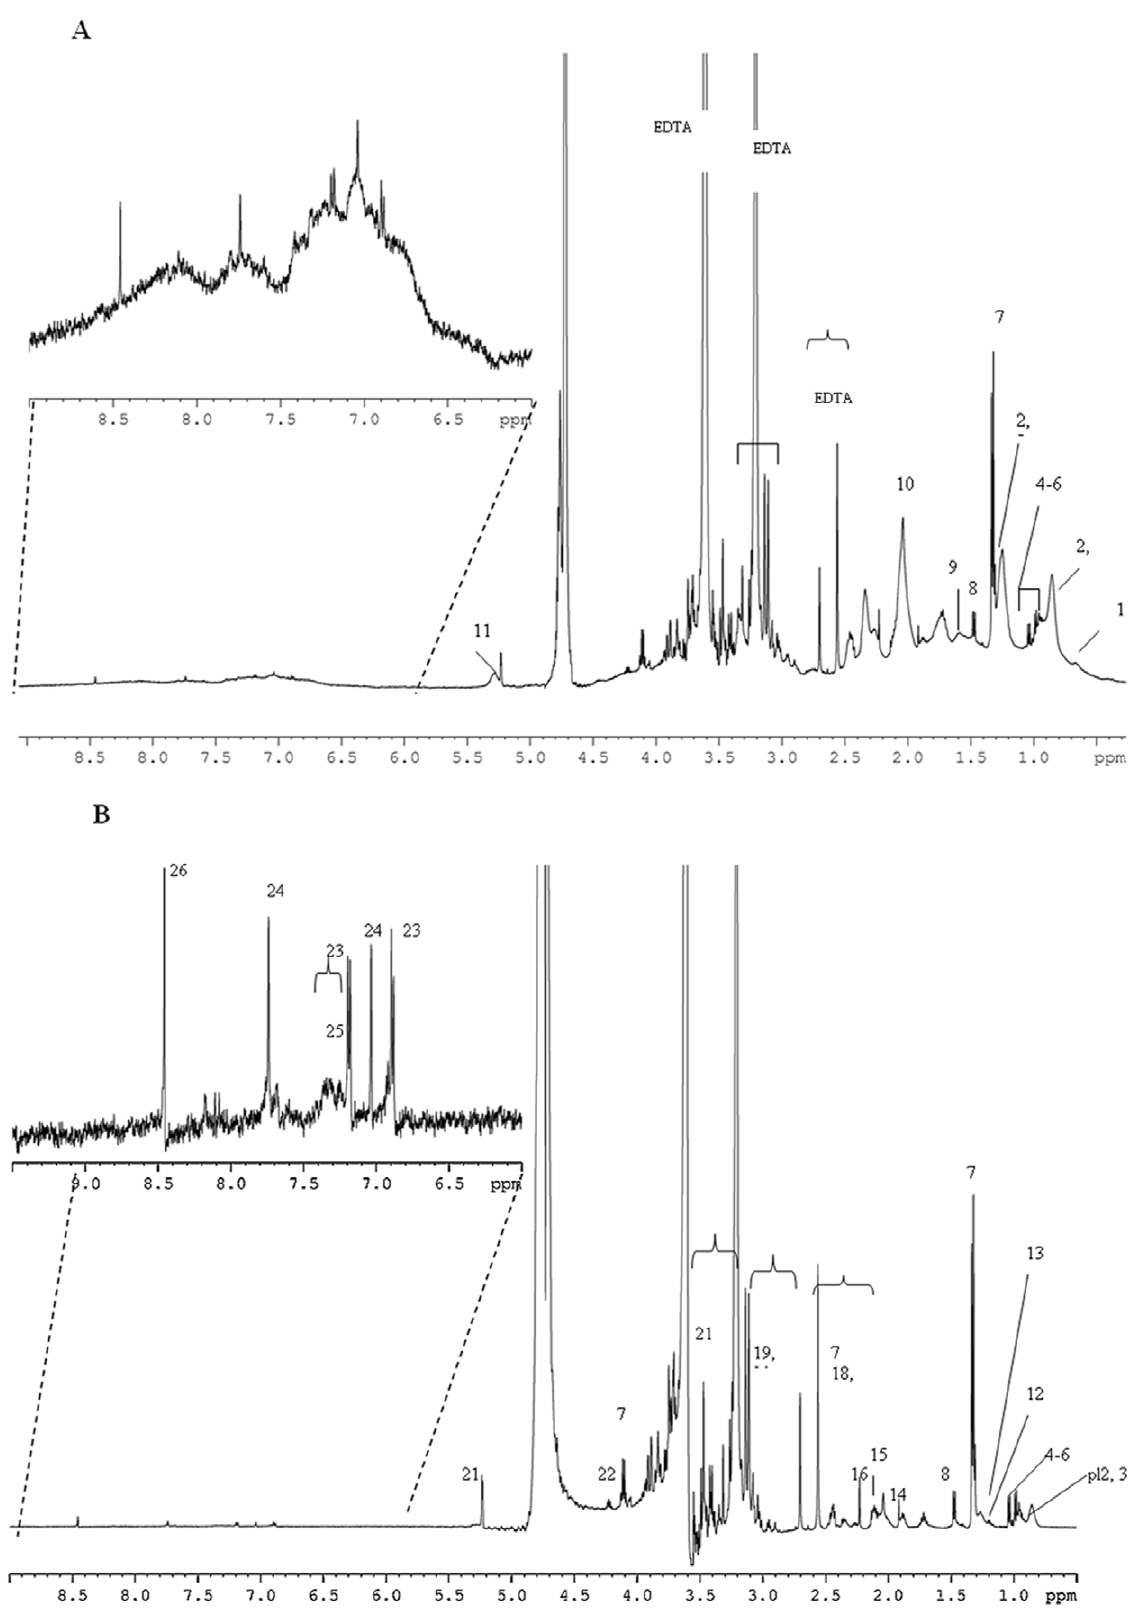
Figure 1. 500 MHz 1 H NMR spectra of arterial umbilical cord plasma from a VLBW delivery. (A) standard NOESYPR1D spectrum; (B) 1D relaxation–edited (CPMG) spectrum. Assignment: 1, HDL; 2, LDL; 3, VLDL; 4, valine; 5, leucine; 6, isoleucine; 7, lactate; 8, alanine; 9; lipid; 10, N -acetyl glycoprotein; 11, unsaturated lipid; 12, b -hydroxybutyrate; 13, lipid; 14, acetate; 15, glutamine; 16, acetone; 17, pyruvate; 18, succinate; 19, albumin- lysyl; 20, creatinine; 21, glucose; 22, threonine; 23, tyrosine; 24, methylhistidine; 25, phenylalanine; 26, formate. doi:10.1371/journal.pone.0029947.g001 PLoS ONE |